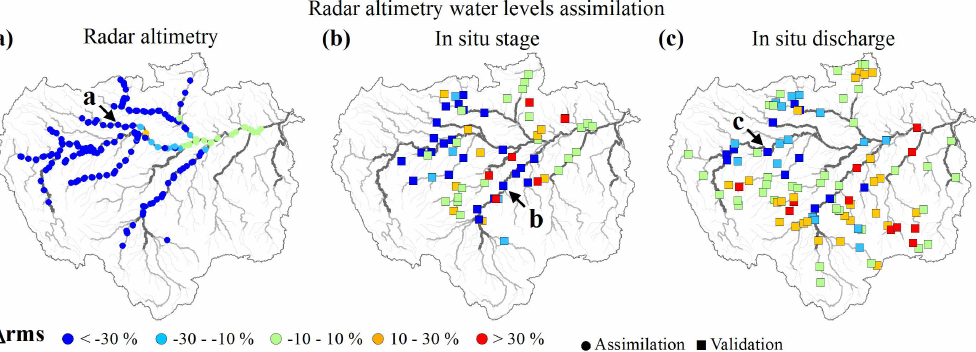
Fig. 4. Evaluation of ENVISAT radar altimetry data assimilation. Spatial distribution of change in root-mean-square error ( 1 rms) at (a) altimetry stations used for data assimilation and stream gauges with (b) stage and (c) discharge data used for